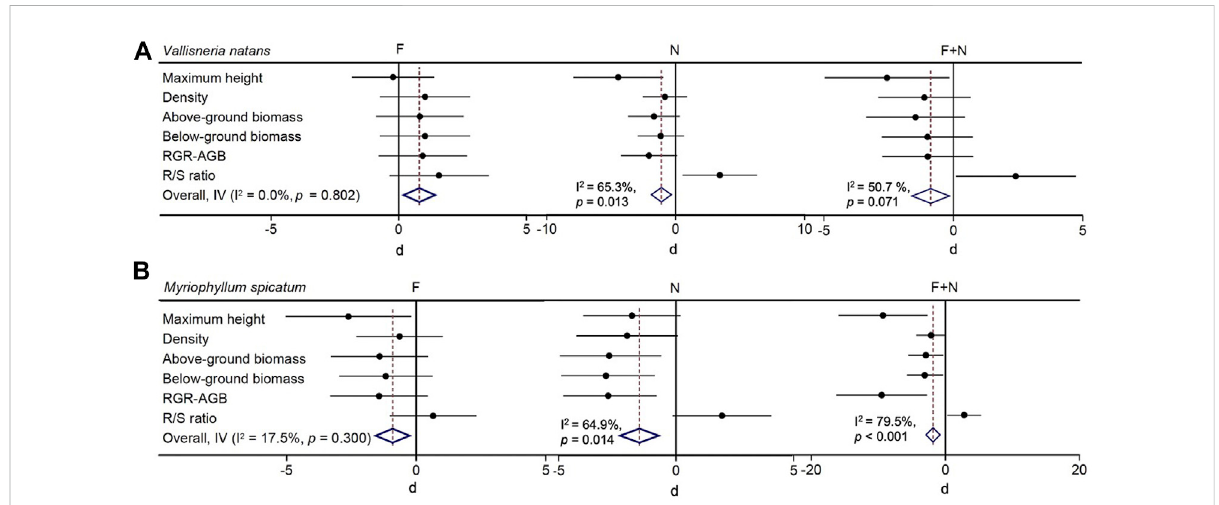
FIGURE 4 Effect sizes (Cohen ’ s d ± 95% con fi dence interval) of individual and combined stressor effects on the growth of Vallisneria natans (A) and Myriophyllum spicatum (B) at the end of the experiment. No signi fi cant effects are inferred when con fi dence intervals cross the zero line. Diamond indicatestheoveralleffect. Thediamond ontheleft-handsideofthezerolineindicatesanegativeeffectandapositive effectontheright-handside. See Figure 1 for the meaning of the various